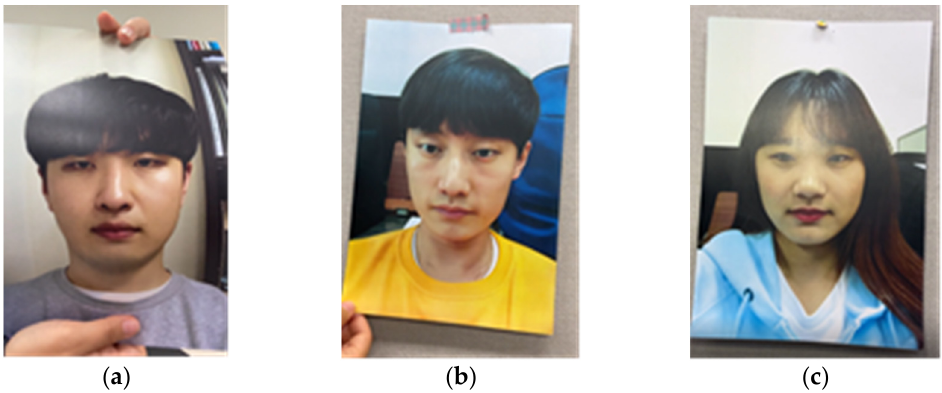
Figure 2. Sample captured images of data for the screening algorithm for video integrity: ( a ) bending photo attack; ( b ) slight shaking attack; ( c ) light movement attack.